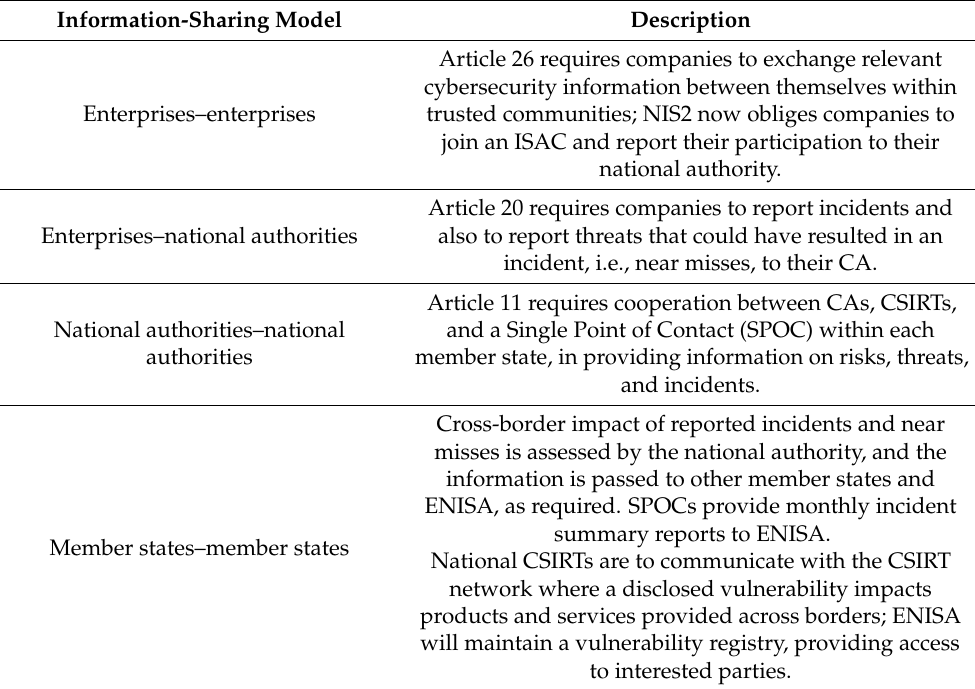
Table 3. Information-sharing models according to the revised directive on Network and Information Security